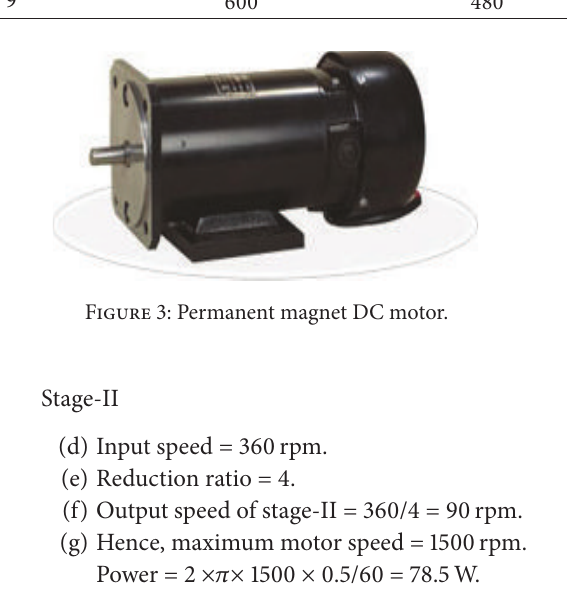
Figure 2: Experimental test rig.